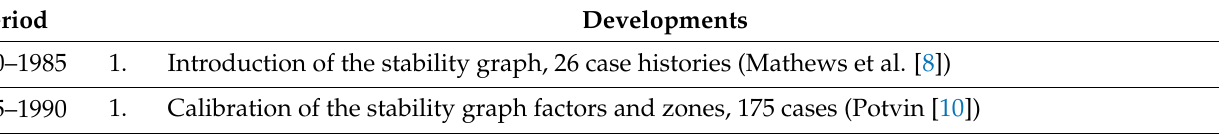
Table 1. Historic overview of the basic stability graph modifications according to Suorineni [13].